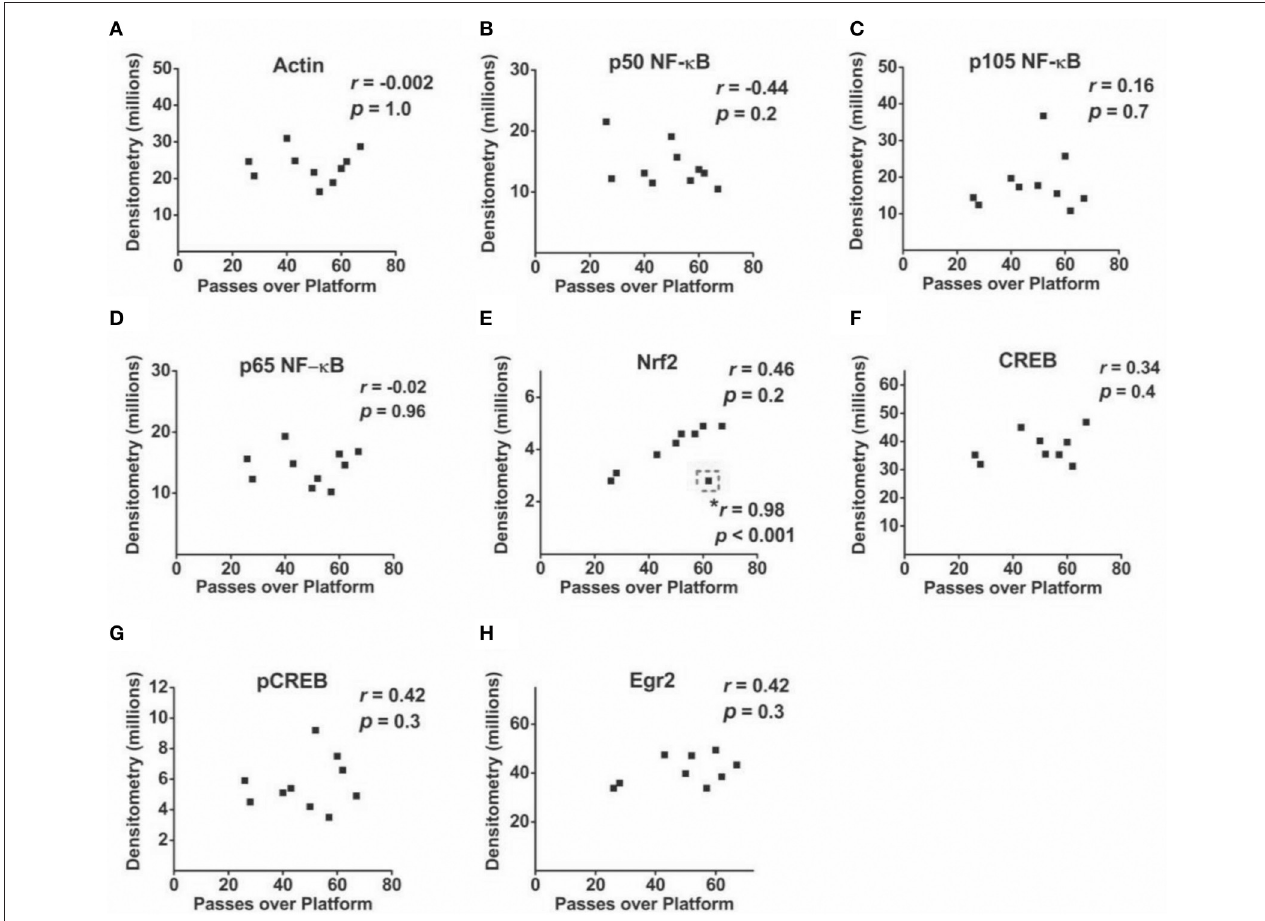
FIGURE 6 | Associations between hippocampal transcription factor protein levels and MWM-retention phase parameter passes over platform. (A–H) Scatterplots and Pearson correlation coefficients between densitometry values (normalized to total protein) from Western blot experiments and the cumulative number of passes over the platform area during the MWM retention phase ( n = 9 –10). * : highly significant positive correlation for n = 8 / 9 tested animals after removal of one inconsistent data point (outlined in dashed